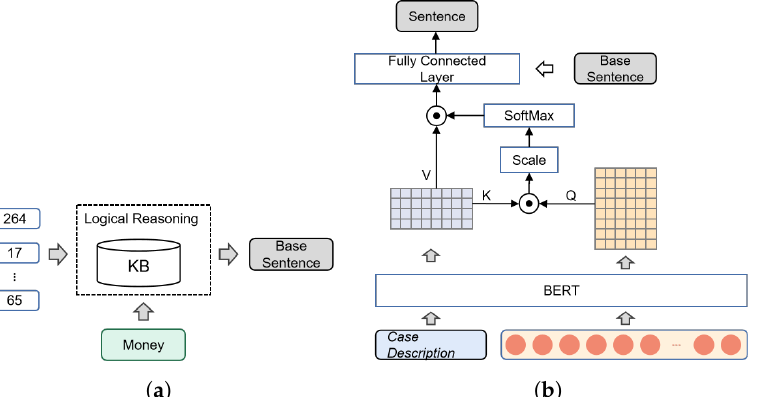
Figure 4. A flow chart of the trial according to the relevant documents. ( a ) Base sentence; ( b ) final